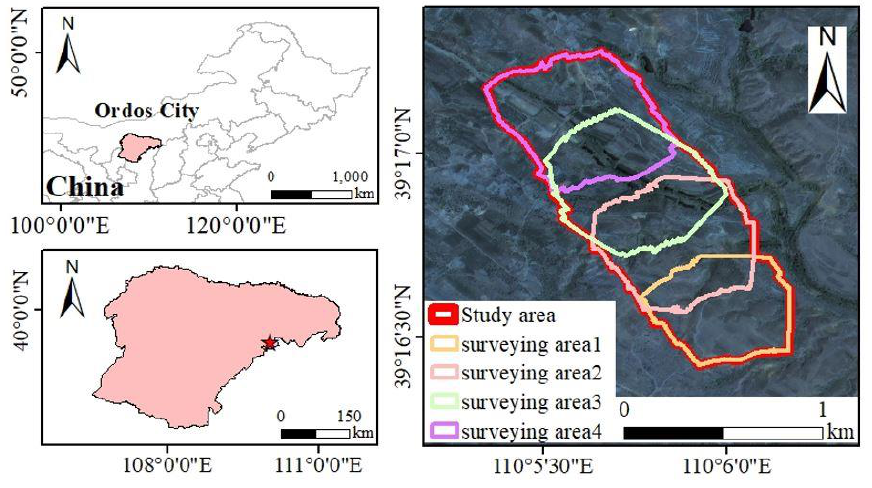
Figure 1. Location of the study